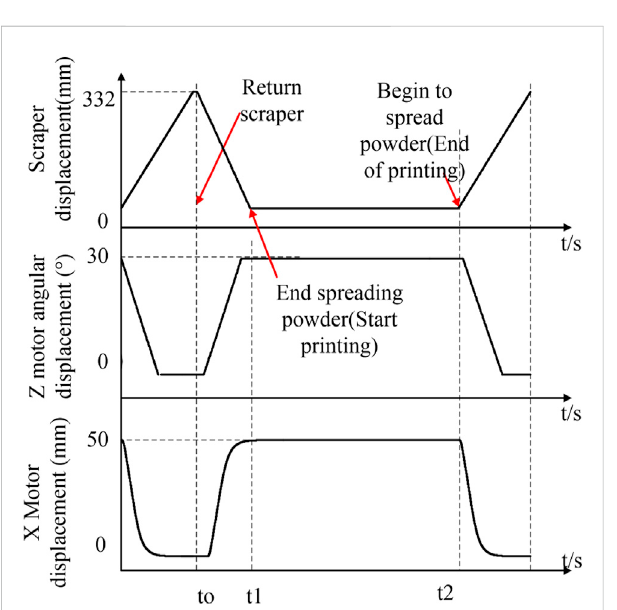
FIGURE 5 The displacement response curves of X motor, Z motor, and scraperincollaborative controlareobtained bySIMULINKandADAMS co-simulation.